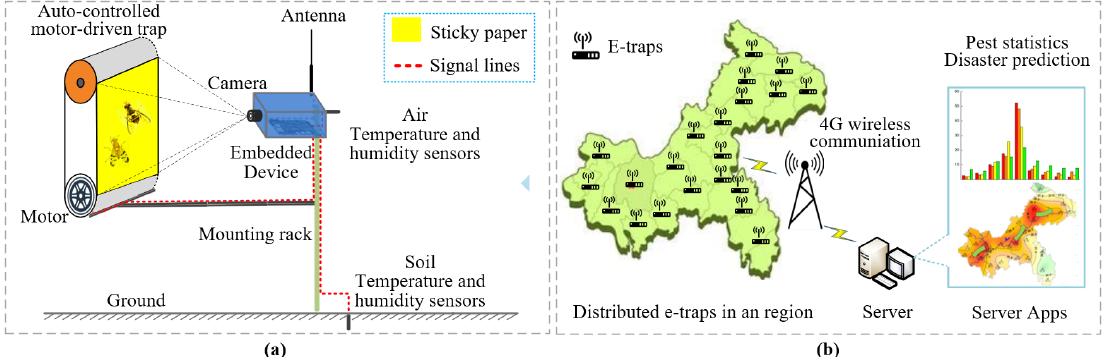
Figure 1. ( a ) Basic structures and functions of the designed e-trap. ( b ) The monitoring system of citrus flies by deploying the distributed